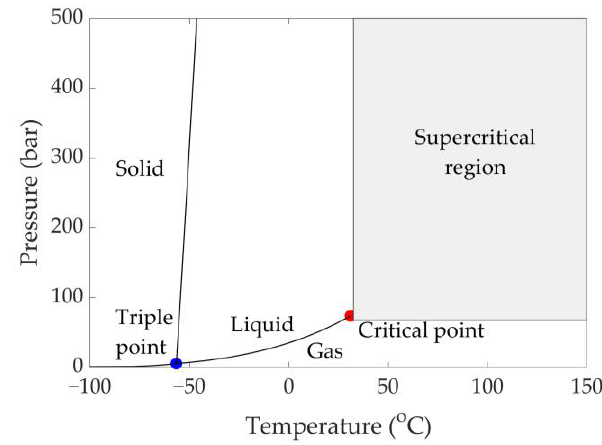
Figure 2. CO 2 phase diagram. Data taken from the literature [109 – 111].